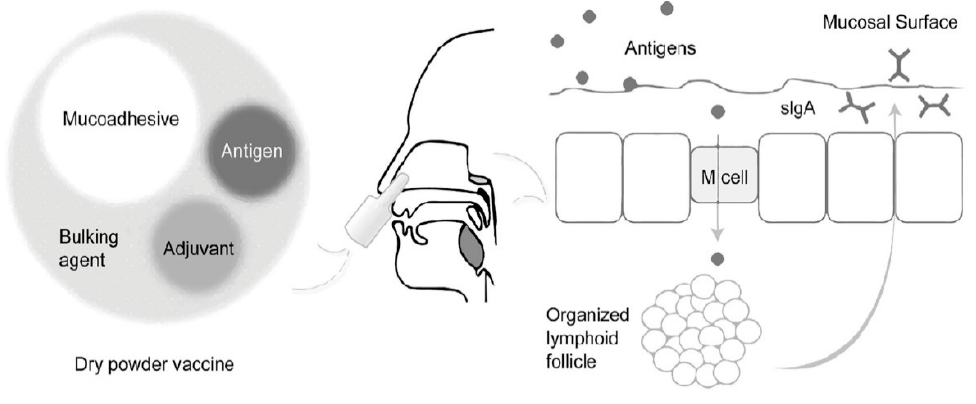
Figure 2. Intranasal administration of a solid dose vaccine [47].